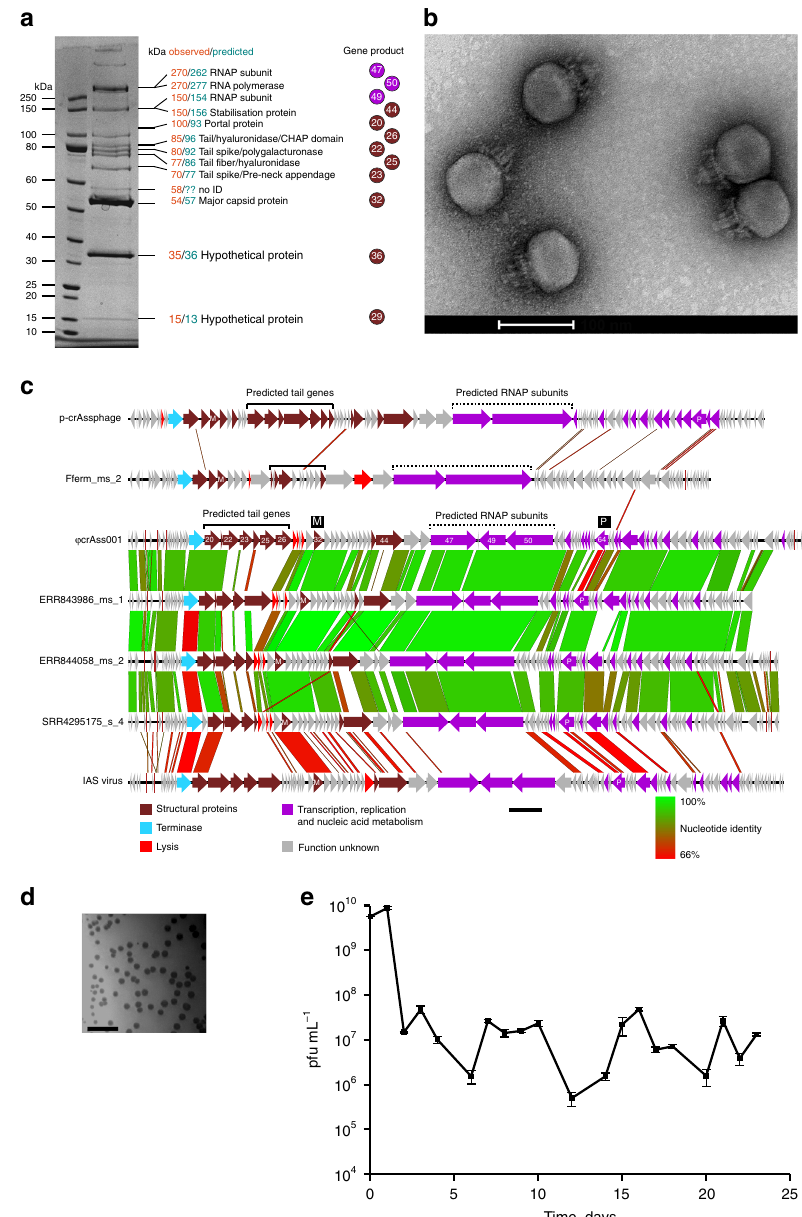
Fig. 3 Φ crAss001 virion structure, related bacteriophages and persistence in a continuous host co-culture. a SDS-PAGE analysis of protein content in Φ crAss001 virions and identi fi cation of selected polypeptides using MALDI-TOF (see supplementary methods for details). b TEM image of uranyl acetate negatively contrasted Φ crAss001 virions, scale bar is 100 nm (×62,000 magni fi cation, accelerating voltage of 120 kV). c Genomic synteny and BLASTn nucleotide sequence homology between Φ crAss001, a group of highly related uncultured bacteriophages (ERR843986_ms_1, ERR844058_ms_2, SRR4295175_s_4, see Guerin et al. 13 for details), and other members of the crAss-like virus family (p-crAssphage, IAS virus, bacteriophage Fferm_ms_2 propagated and visualised from a faecal fermentor system 13 ); highly variable tail genes region is marked a solid bracket; region containing giant open reading frames of predicted RNA polymerase subunits is highlighted with dotted bracket; M, major capsid protein; P, DNA polymerase, scale bar is 5 kb. d Plaque morphology of Φ crAss001 after 48 h incubation in a 0.3% FAA agar overlay with B. intestinalis 919/174 as host, scale bar is 1 cm. e Persistence of